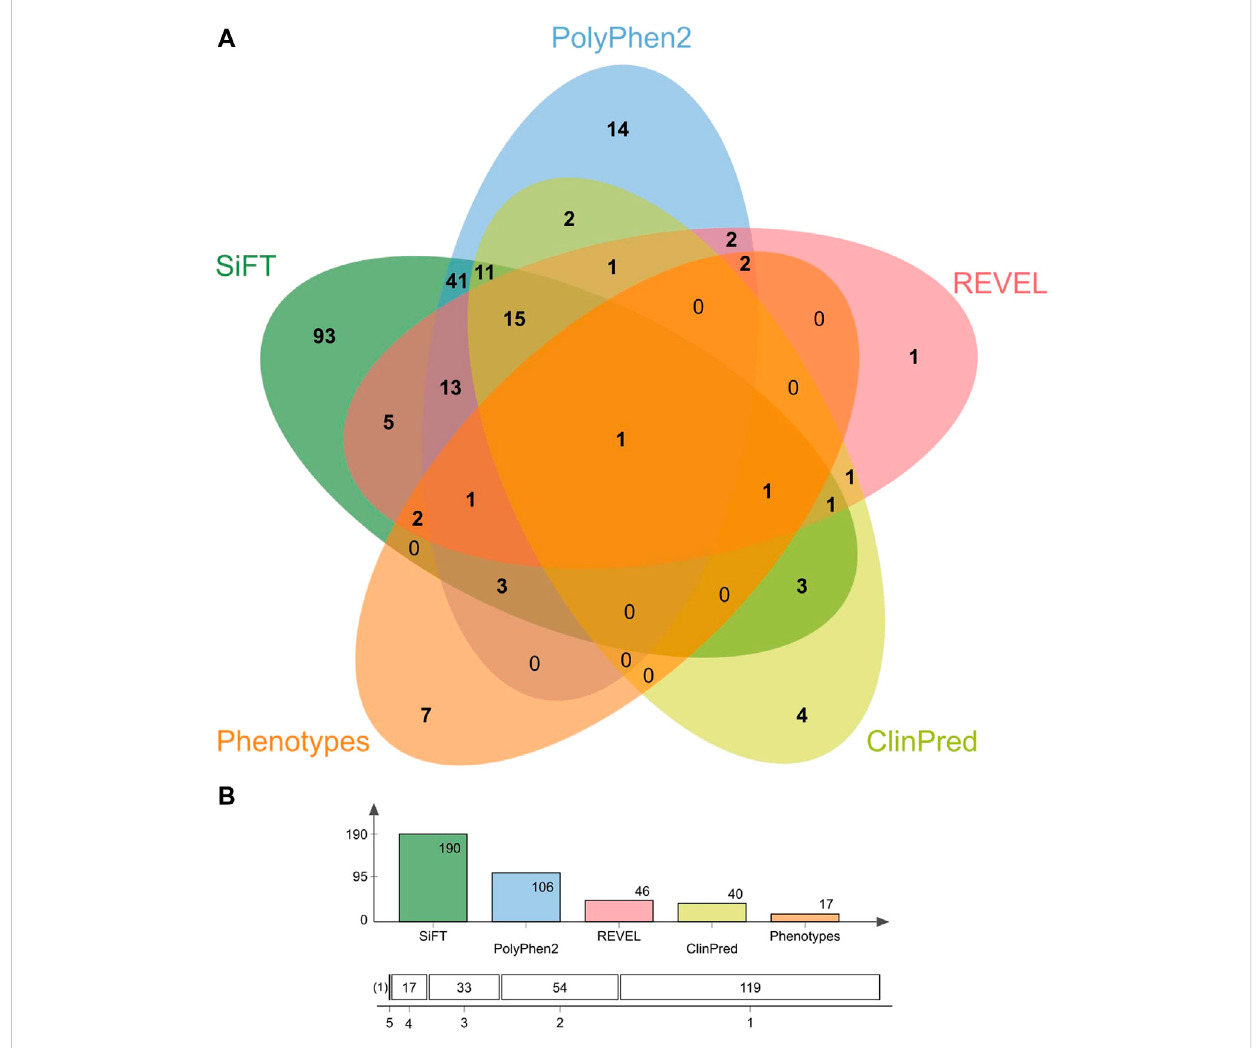
FIGURE 8 Concordancebetweensourcesusedtoidentifyvariantsofinterestaccordingtotheirpathogenicityorassociationwithalterationsinthelipidpro fi